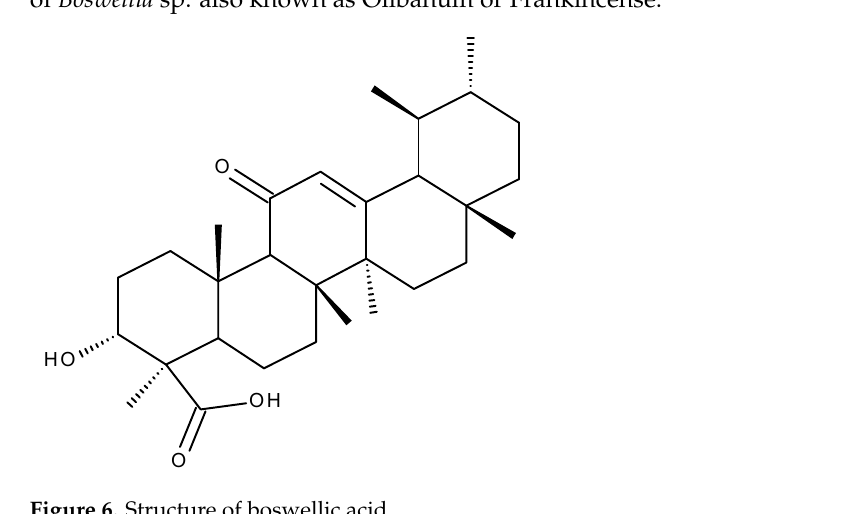
Figure 7. Biological activities of boswellic acid. Parts of the figure were drawn by using pictures from Servier Medical Art. Servier Medical Art by Servier is licensed under a Creative Commons Attribution 3.0 Unported License (https://creativecommons.org/licenses/by/3.0/, accessed on 2 August 2022). 3.1. Anti-Inflammatory Activity In terms of anti-inflammatory molecular mechanisms, the recent work of Zang et al. described the interaction between BoA and the glucocorticoid receptor (GR). By em-